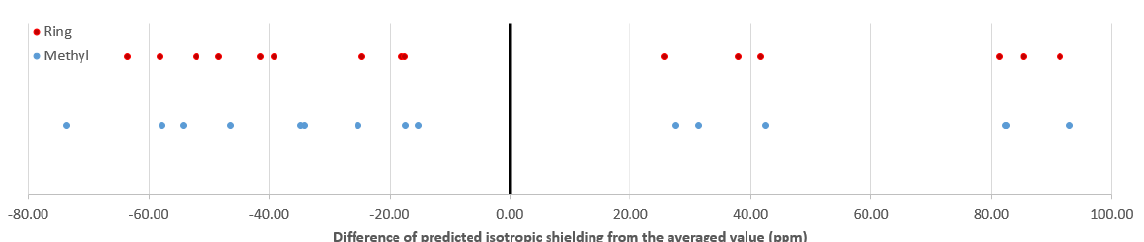
Figure 7. Difference of the predicted isotropic shielding of individual 13 C nuclei from the averaged value at 298